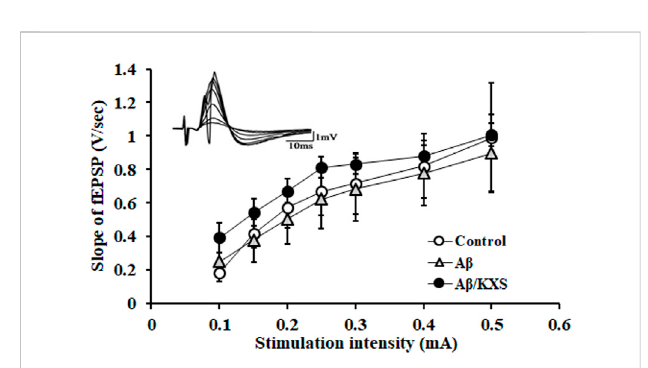
FIGURE 2 I – O curve recording in the experimental groups. There were no signi fi cant differences among these three groups. The waveforms of fEPSPs at different stimulation intensities are shown at the top left upper corner. Each value represents the mean ±